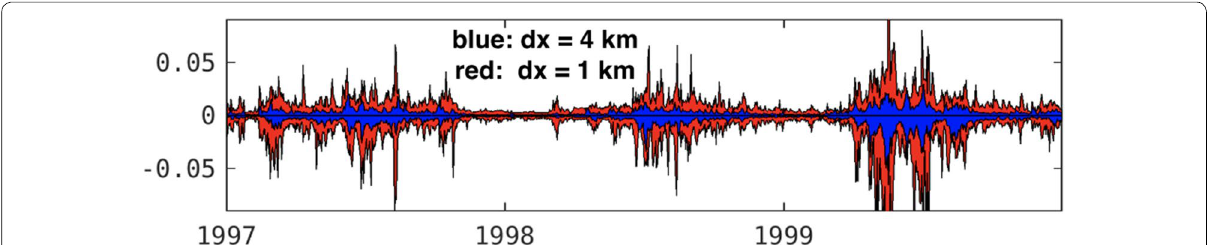
Fig. 18 Submesoscale nutrient flux. A time series of a scatterplot of the product of w and inorganic N for all spatial points at 50 m depth in the California current in the region 20–200 km offshore. A submesoscale-permitting simulation ( dx = 1 km; red) shows much greater variability than a mesoscale-resolving one ( dx = 4 km; blue). In this eastern-boundary upwelling system, both simulations have a mean w ′ N ′ < 0 , indicating “eddy quenching”, i.e., a reduction in primary productivity by burial of unconsumed nutrients by eddy fluxes along the descending isopycnal surfaces. The SMCs enhance w ′ N ′ by about 40% in this comparison (Kessouri et al.